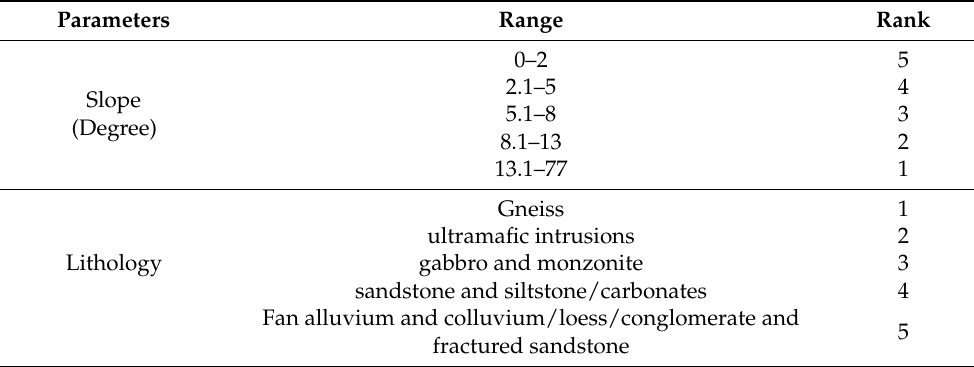
Table 1. Ranking of the suitability